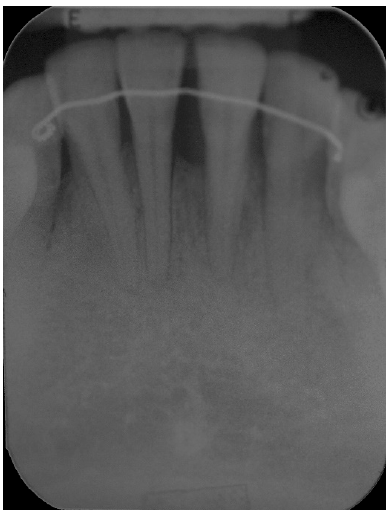
Figure 10. One-year post-operative radiograph, improvement in bone support, especially around the central left incisor is evident, compared to the pre-operative x-ray, the bone defect around the left central incisor has largely been reduced.